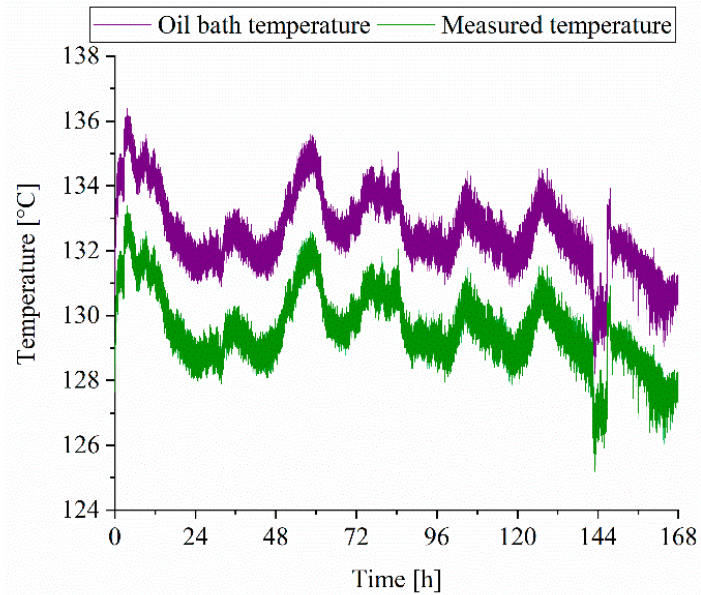
Figure 10. Long-time experiment showing the stability of the reference thin film thermocouple.